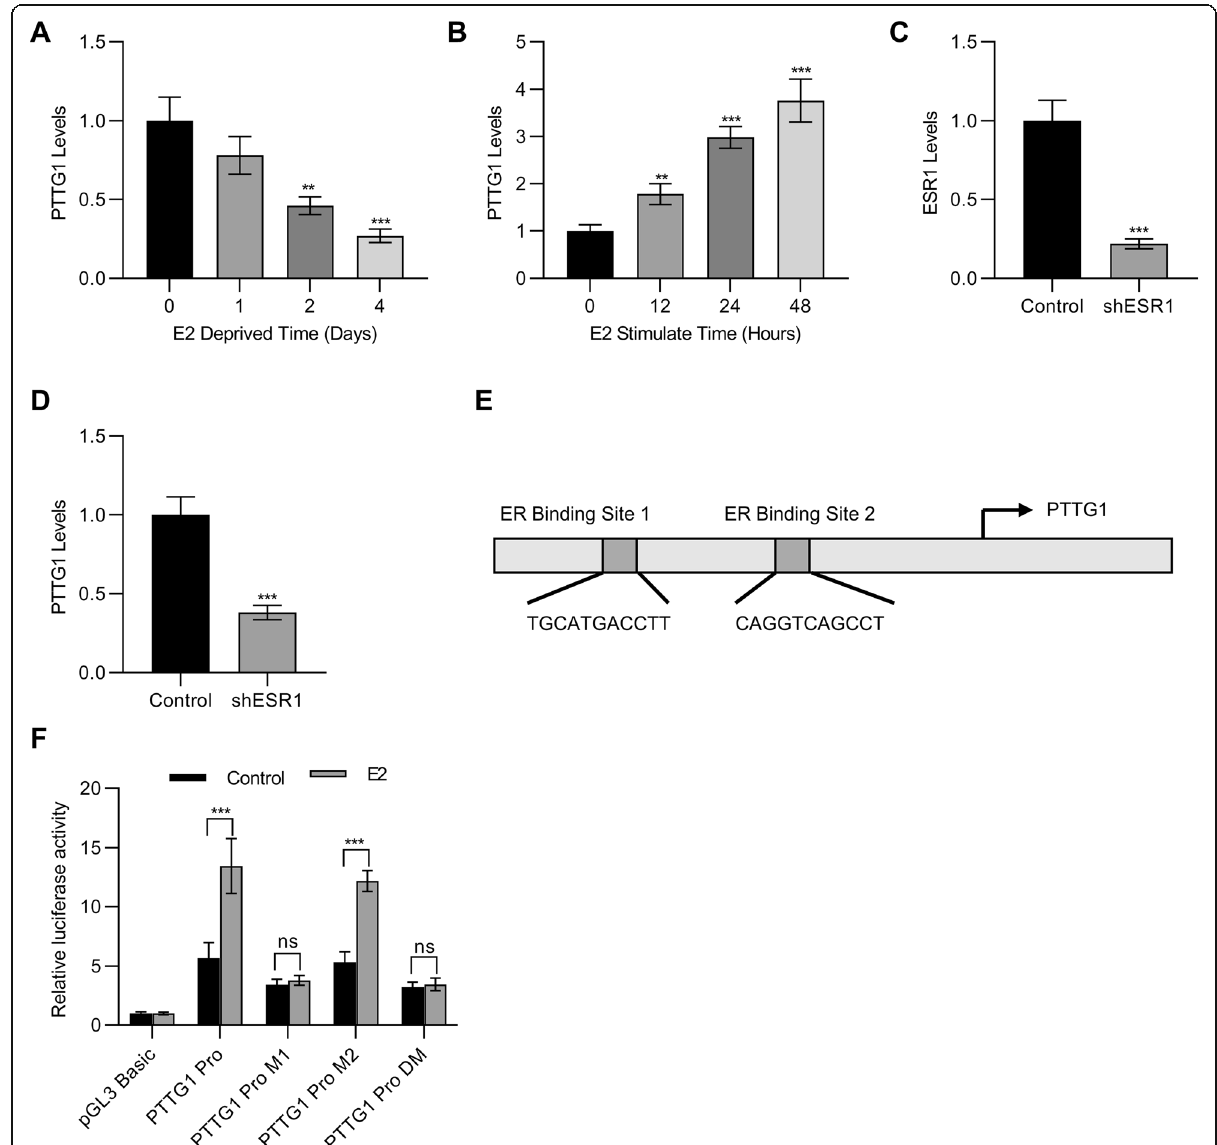
Fig. 3 PTTG1 expression was regulated by the levels of estrogen. a-b qPCR was employed to detect the mRNA levels of PTTG1 in MCF7 cells in the presence or absence of estrogen (100 nM). c-d shRNA was used to knock down the ESR1 and qPCR was applied to examine the mRNA levels of ESR1 and PTTG1 in the cells. e ER binding sites were predicted using rVista (https://rvista.dcode.org/) and two possible binding sites were found. f Mutations were introduced in the ER binding sites and luciferase reporter assay was performed to confirm the ER binding sites on the promoter on the PTTG1.MCF7 cells were co-transfected with plasmids and vehicles or estrogen. n = 3 for all experiments. Data were represented as mean ± S.D. ** P < 0.01, *** P < 0.001, ns indicates no